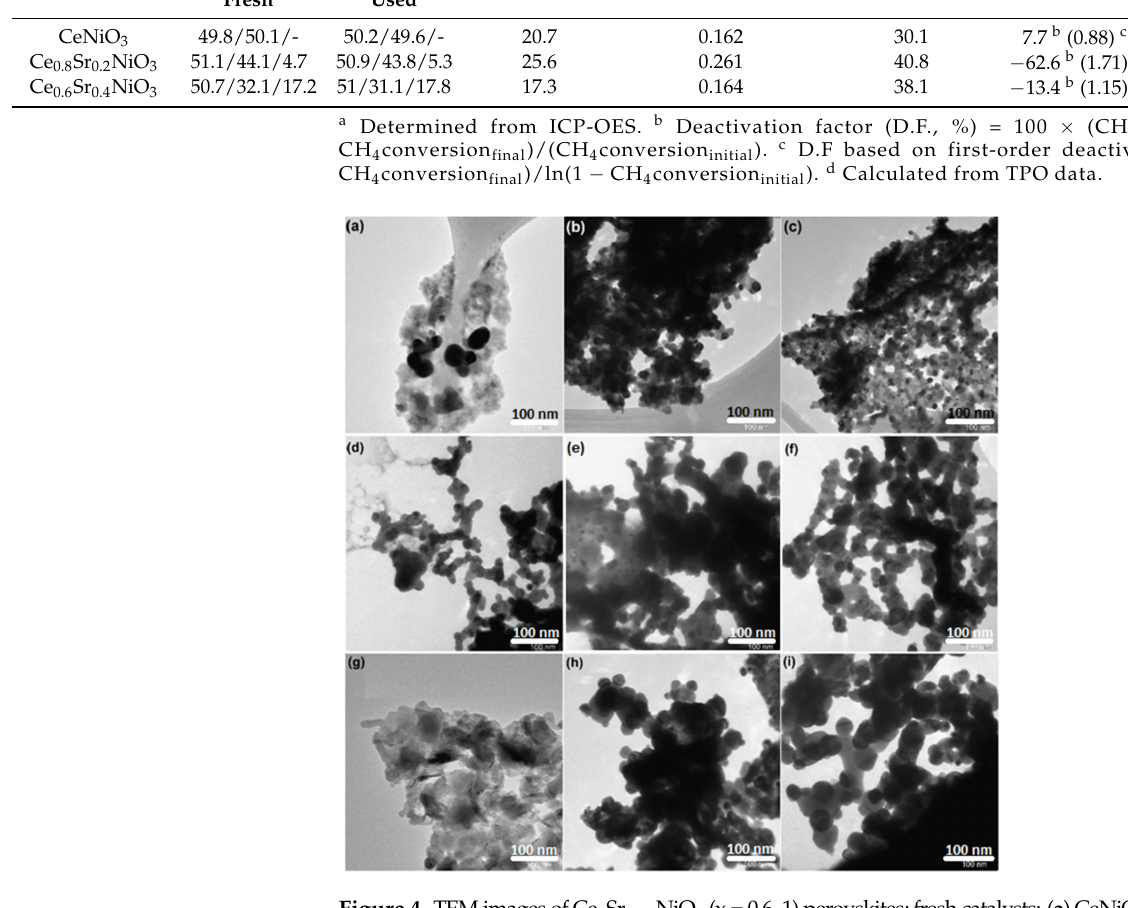
Figure 4. TEM images of Ce x Sr 1 − x NiO 3 (x = 0.6–1) perovskites; fresh catalysts: ( a ) CeNiO 3 , ( b ) Ce 0.8 Sr 0.2 NiO 3